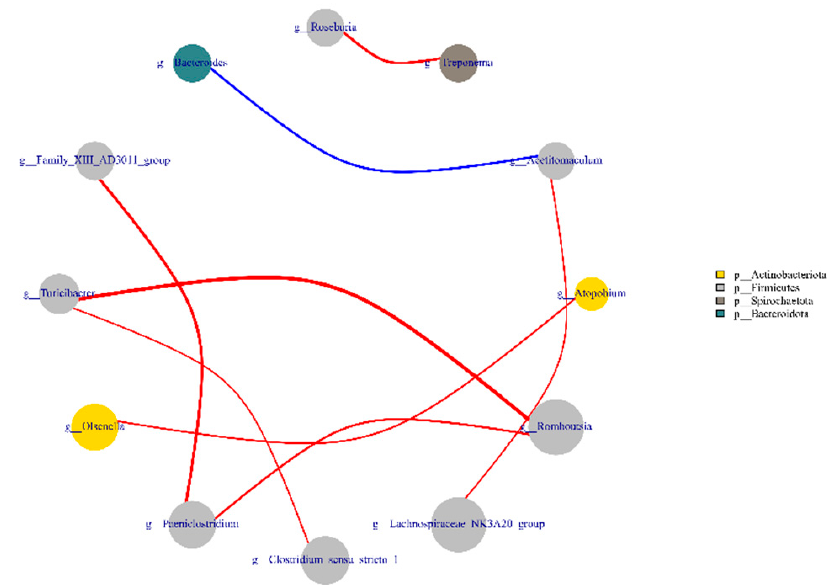
Figure 5. Analysis of co-occurrence network among microbial genera. Each co-occurrence pair between genus-level microbiota has an absolute Spearman rank correlation, with the red line indicating a positive correlation between two species and the blue line showing a negative correlation between two species, while the thickness of the line represents the magnitude of the correlation, with the thicker line representing a more robust correlation and the thinner line representing a weaker